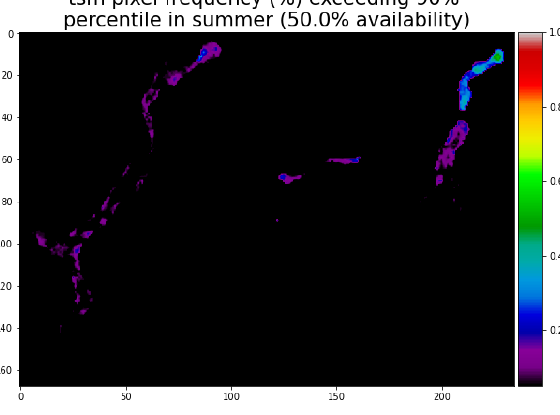
Figure 16. TSM spatial pattern map